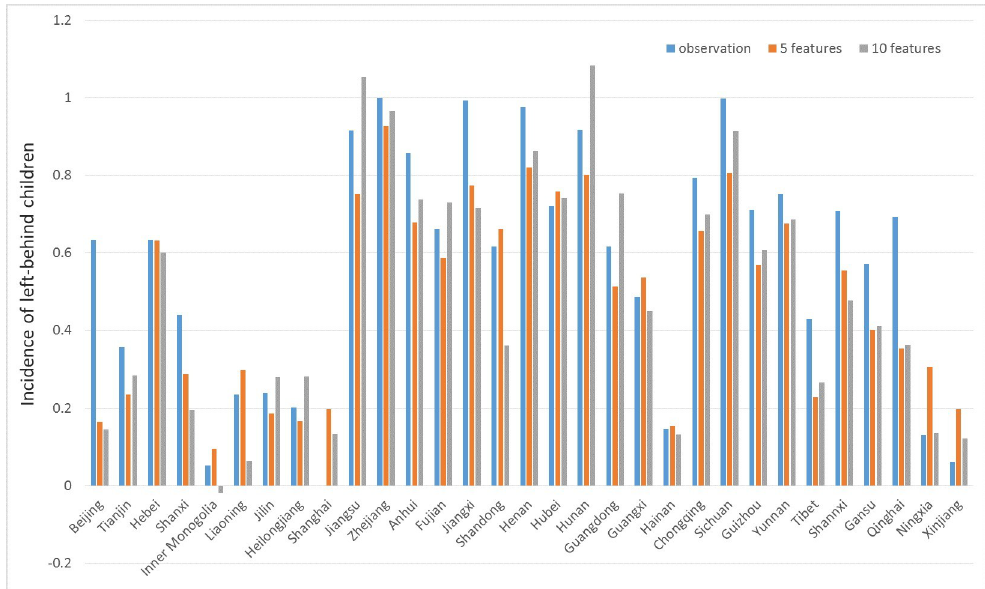
Fig 8. Prediction results for SVR models by Wrapper Method.